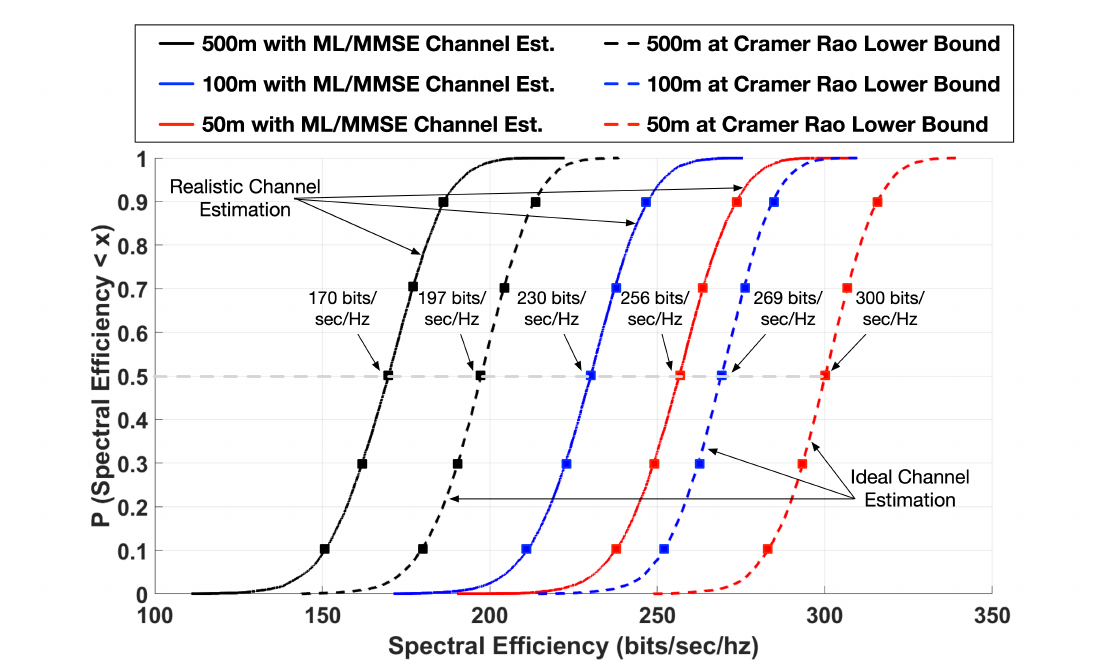
Figure 5. Cumulative distribution functions of spectral efficiencies in bits/sec/Hz for K = 3 in single hexagonal cells of radius 50 m, 100 m, and 500 m for Indoor A channel scenarios [25]. Results are